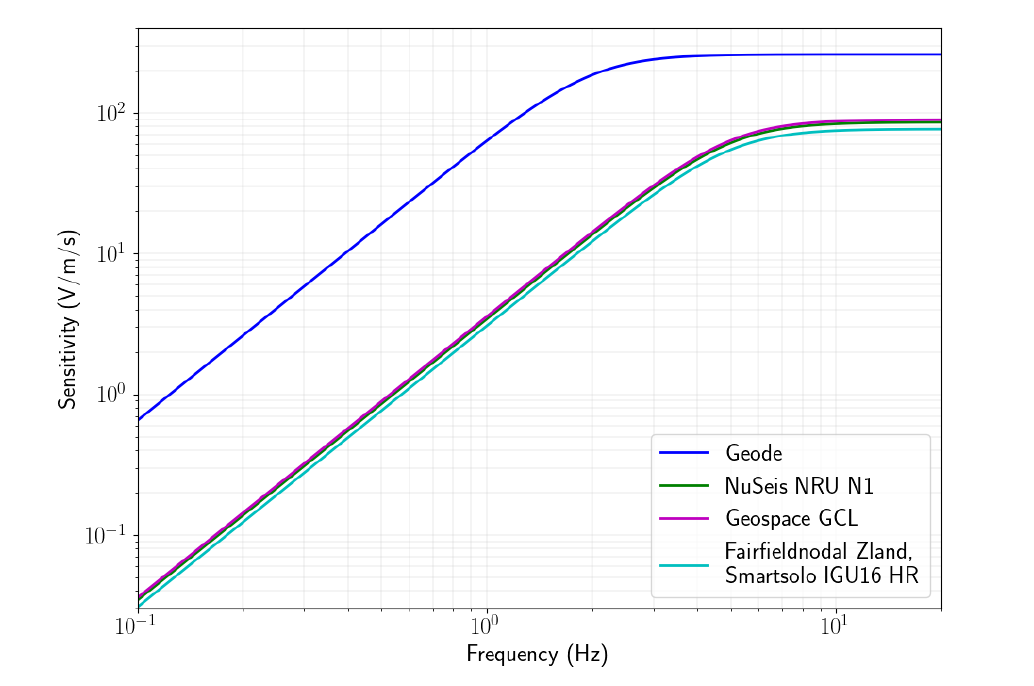
Figure 2. Instrument response function for geophones used in several popular nodal geophones compared to the geophone used in the